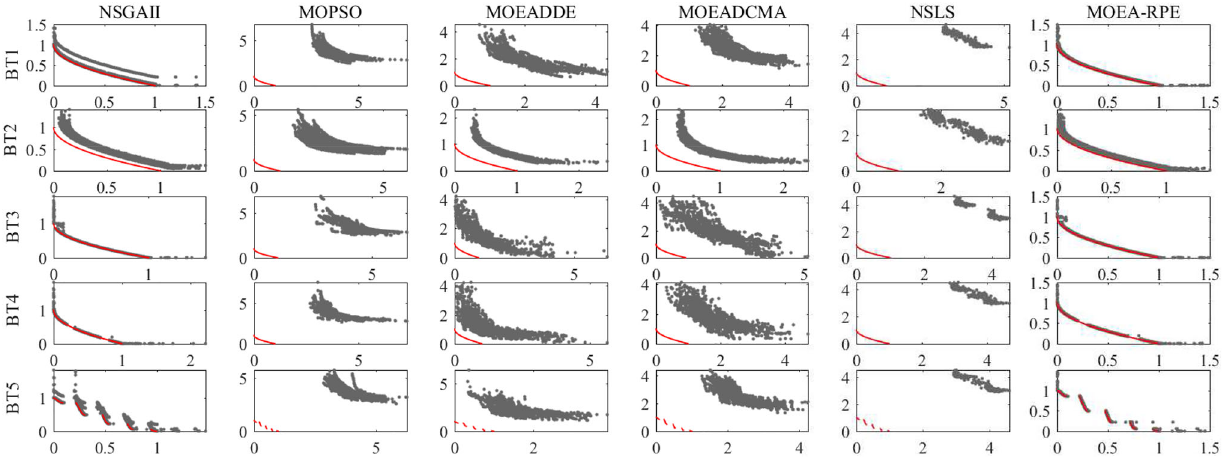
Fig. 4 The obtained solutions from 30 independent runs on